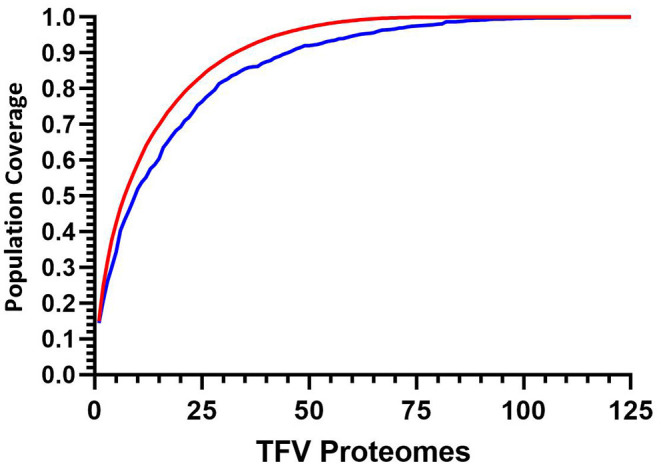
Cumulative coverage distribution plots of full length transmitted founder gag sequences using a 3-select coverage model and a 1% Binding Threshold, 3-Select best (red), and 3-Select random (blue). P-values calculated using Kolmogorov-Smirnov test.